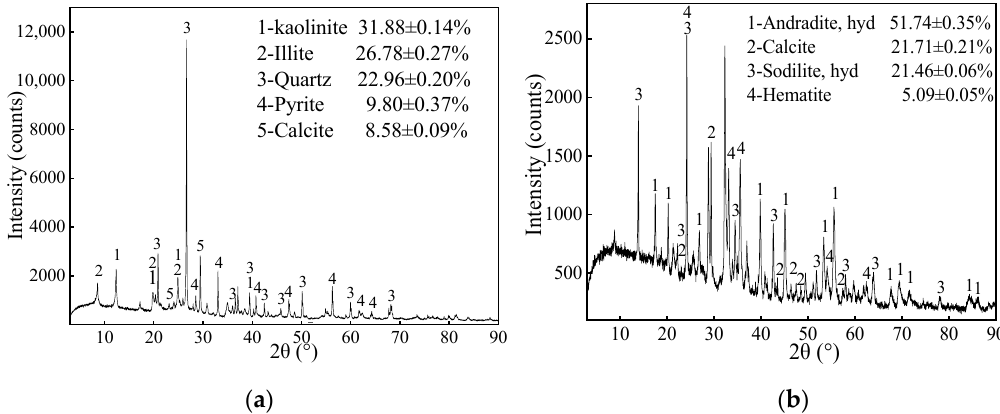
Figure 3. The XRD patterns of ( a ) coal gangue, ( b ) red mud, and the mineralogical compositions (%, mean ± SD, n = 3).